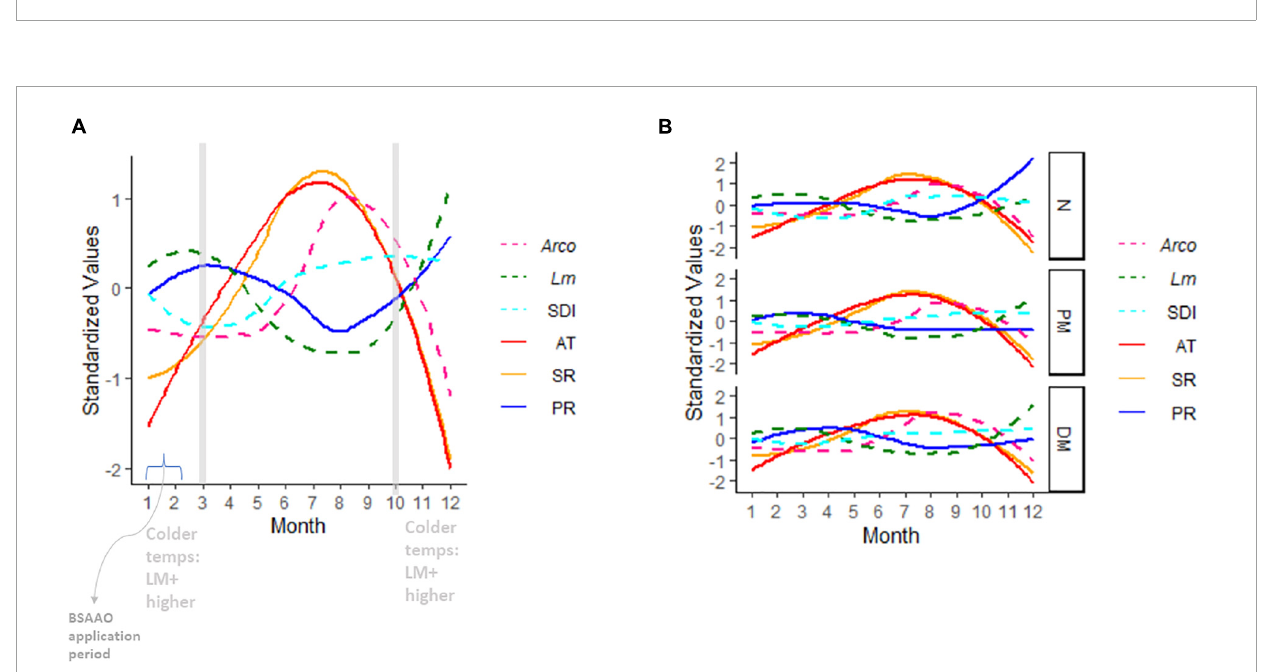
FIGURE6 Seasonal trends in OH air temperature (AT), precipitation (PR), and solar radiation (SR). Overlaid are Lm soil prevalence, Arcobacter ( Arco ) prevalence, and Simpson’s diversity index (SDI) in OH soil. AT, PR, and SR are 48 h moving averages. All variables are standardized to the same scale using the R standardize function in the robustHD package (Alfons, 2019). Soil amendment groups are aggregated in (A) and grouped in (B) . BSA, biological soil amendment; BSAAO, biological soil amendments of animal origin; PM, poultry manure; DM, dairy manure; N, not amended with BSA or BSAAO; AT, 24 h average of air temperature; SR, solar radiation; PR, precipitation; SDI, Simpson’s diversity